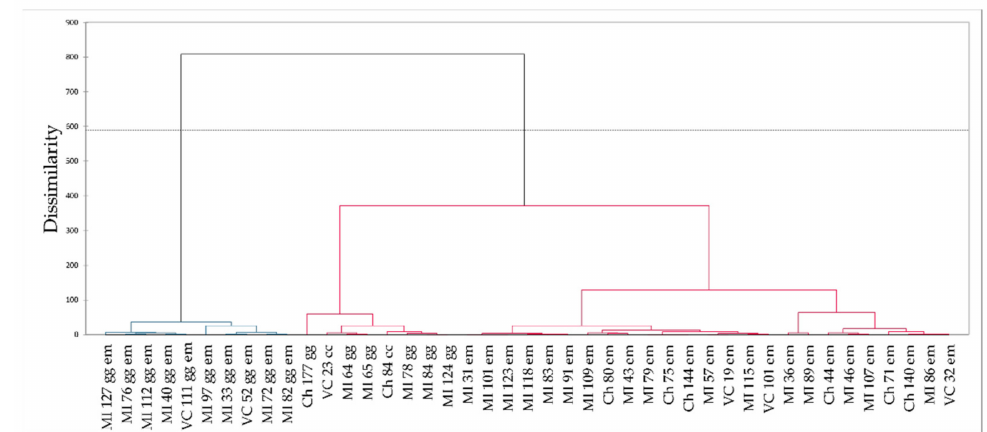
Figure 21. Dendrogram obtained by means of HCA on the FORS spectra of green gemstones.